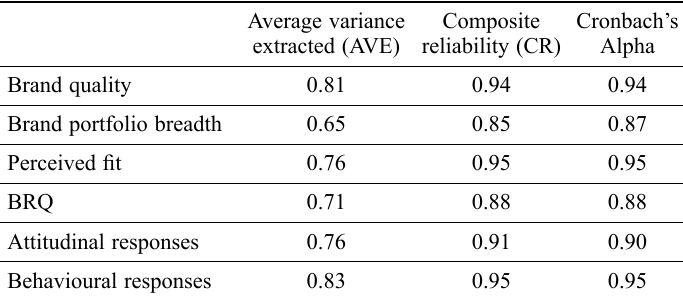
Table 2. Measure